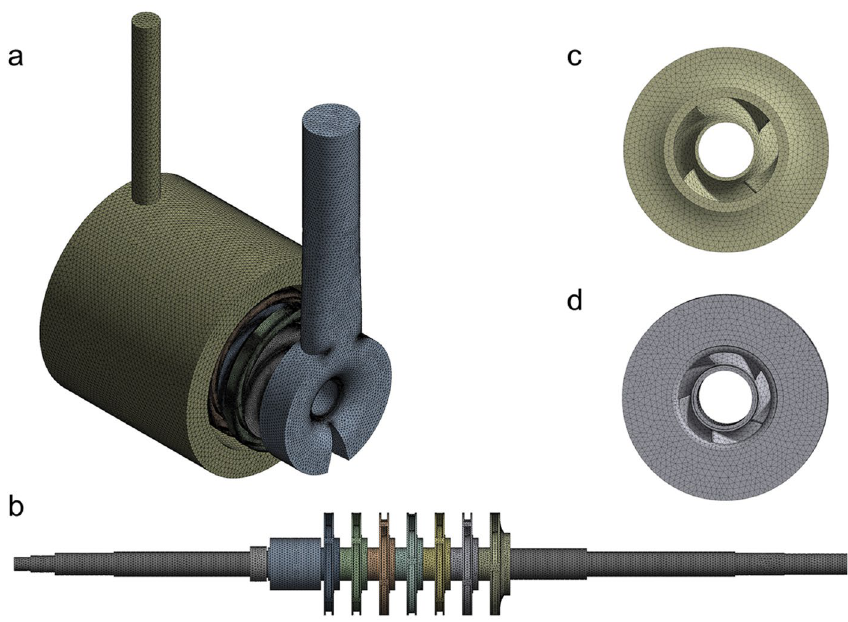
Figure 3. Fluid domain and solid domain meshing ( a ) Fluid domain. ( b ) Solid domain. ( c ) First impeller. ( d ) Other impellers.